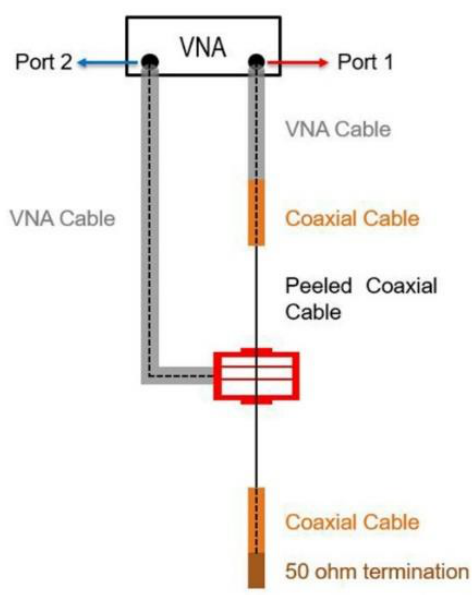
Figure 12. PD experimental set-up for the antenna test.